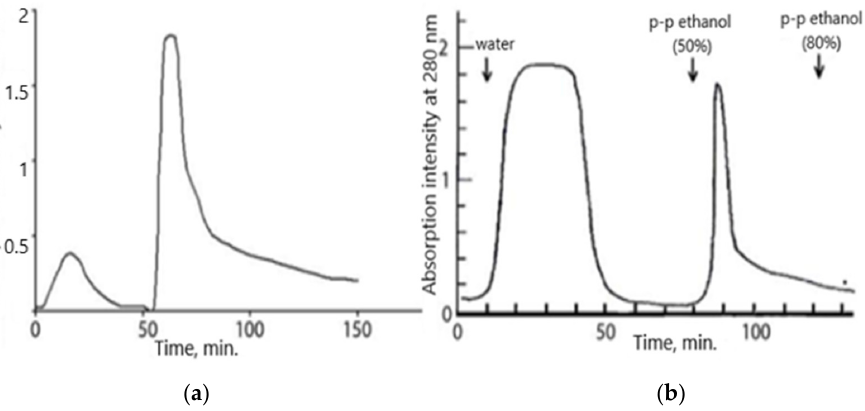
Figure 2. Fusicoccin chromatographic separation curves on column with carbonized RH ( a ) and octylsepharose 4B-CL organic gel ( b ). Reprinted with permission from Ref. [14]. Copyright 2007, KazNU.